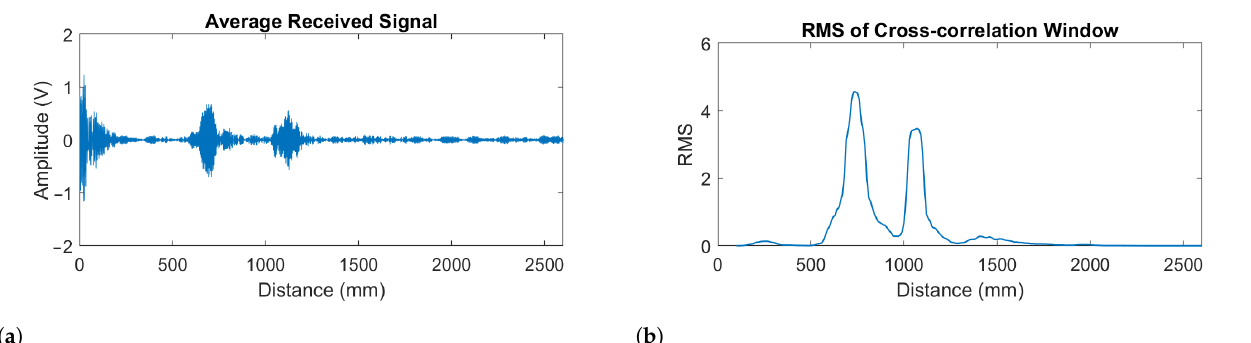
Figure 10. Example plots showing ( a ) the received signal with all the microphone rings averaged, and ( b ) the corresponding windowed RMS (root mean square) representation of the cross-correlated